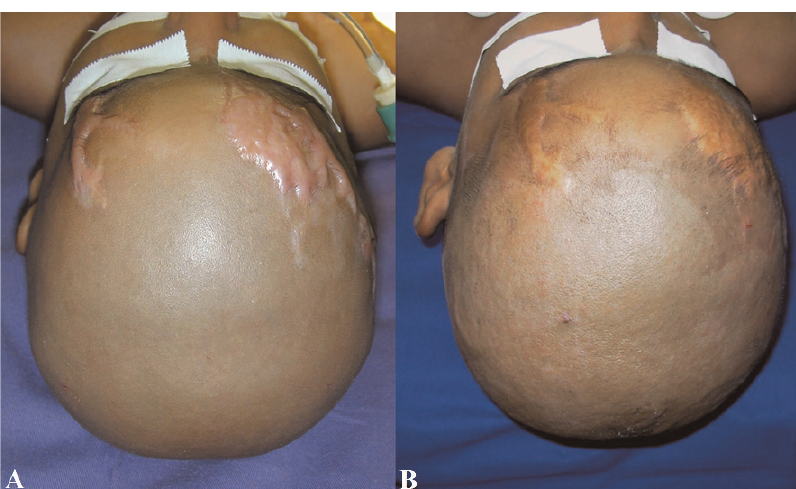
Figure 1 - Hypertrophic scar regression in a burned child after four years (A and B). Hypertrophic scars are usually raised, although rarely elevated more than 4 mm above the skin; red or pink in color; hard; and pruritic. Additionally, these scars do not extend beyond the general geographic margins of the wound and tend to regress over time.